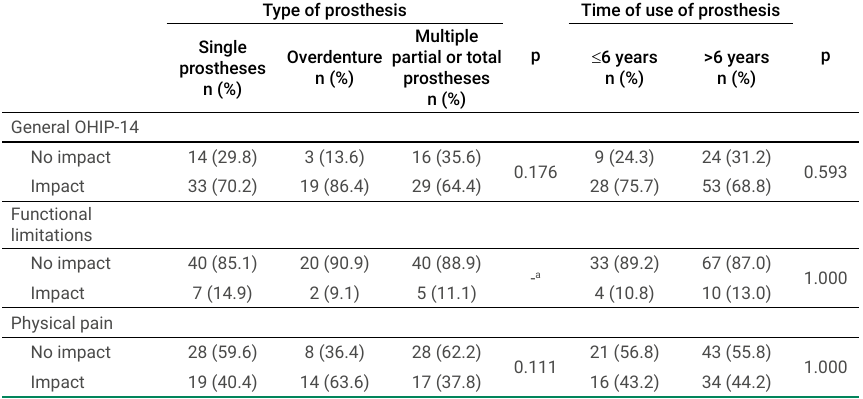
Table 2. Distribution of the impact of oral health on QoL, as evaluated by OHIP-14, with regard to the type of prosthesis used and time of use of prosthesis. Type of prosthesis p Overdenture n (%) n (%)